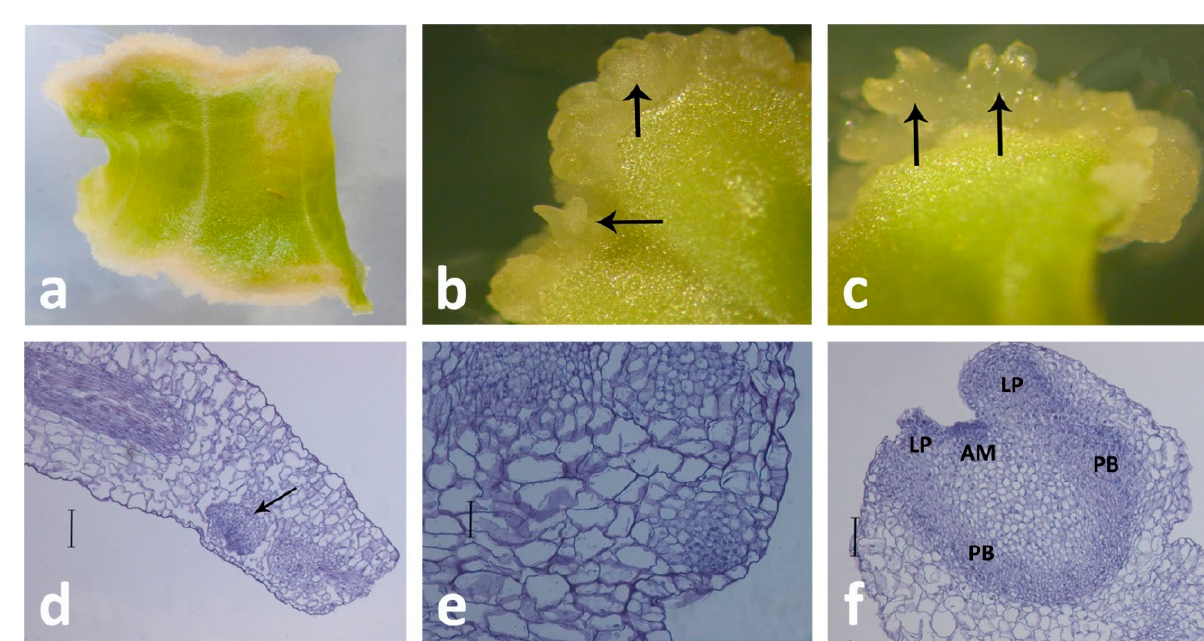
Figure 2. SE in Centaurium erythraea leaf culture. ( a ) Embryogenic callus developed at the edge of the leaf explant treated with 2,4-dichlorophenoxyacetic ac(2,4-D) and N -(2-chloro-4-pyridyl)- N’ -phenylurea (CPPU) in darkness, ( b ) and ( c ) Somatic embryos at different stages of development (arrows), ( d – f ) Micrographs showing somatic embryo development on a leaf explant, ( d ) Histological appearance of a meristematic center (arrow) in the subepidermal layer of the leaf explant. Scale bar indicates 200 µ m, ( e ) Globular somatic embryo. Scale bar indicates 100 µ m, ( f ) Cotyledonary somatic embryo with apical meristem (AM), leaf primordial (LP), and provascular bundles (PB). Scale bar indicates 200 µm.